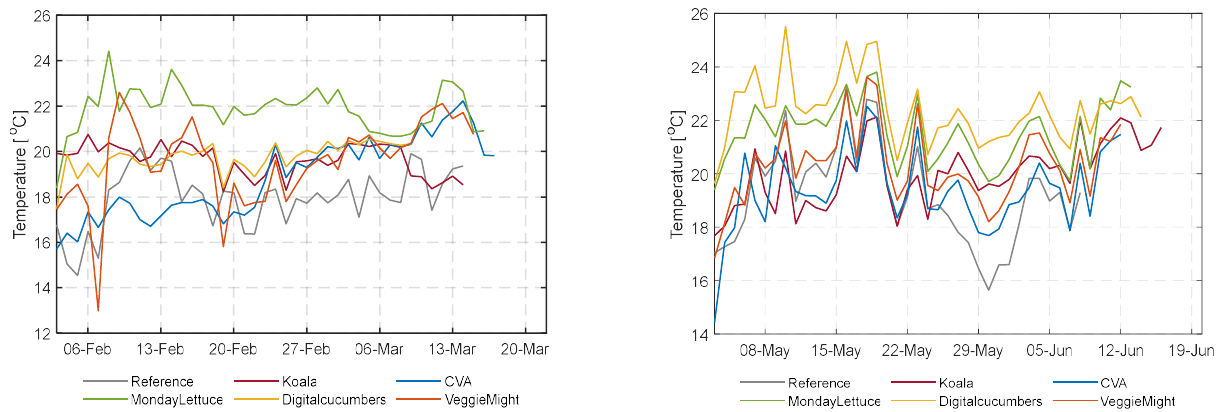
Figure 7. Average daily temperature (°C) of all compartments during the first and second cultivation.